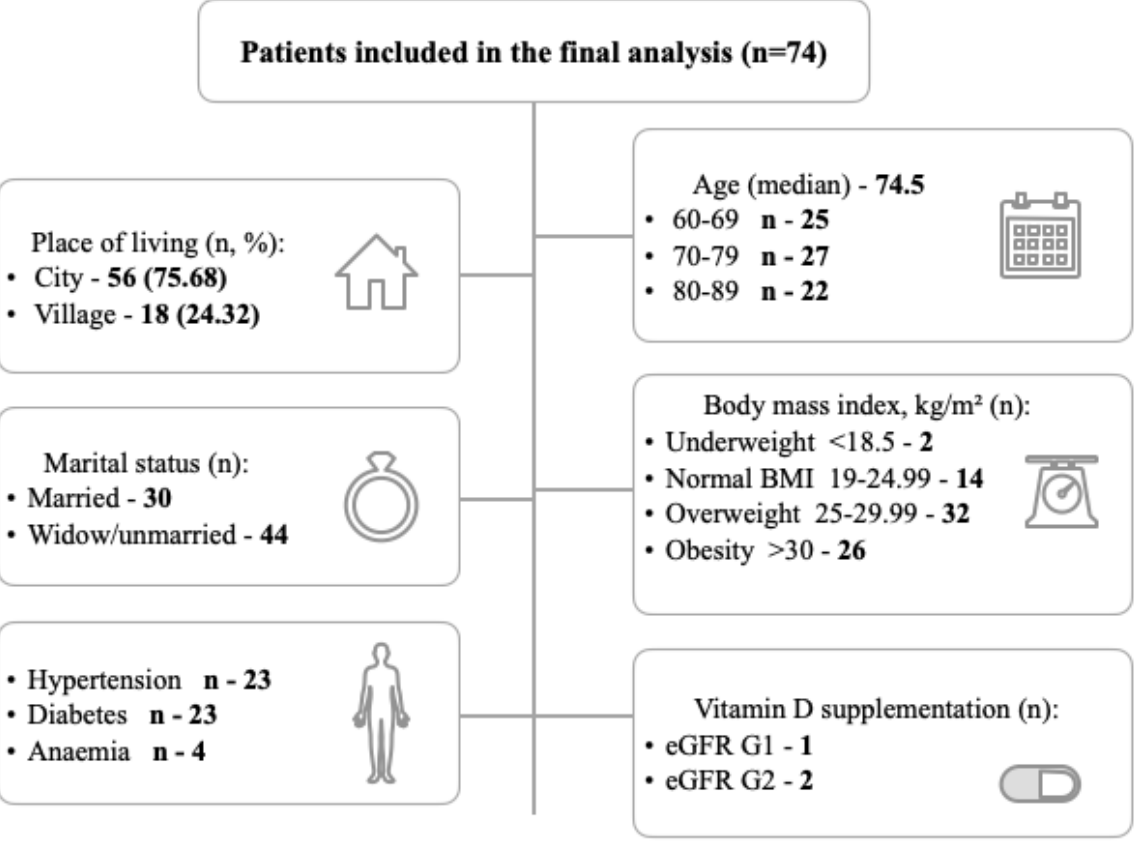
Figure 1. Flowchart of the patient selection, classification, and baseline characteristic.